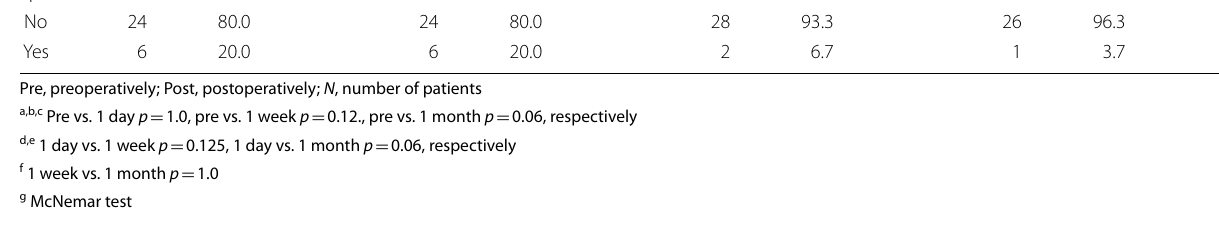
1.0, pre vs. 1 week p =